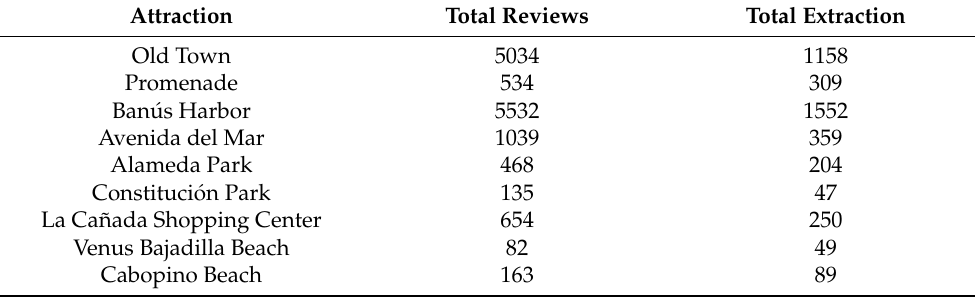
Table 2. Extraction